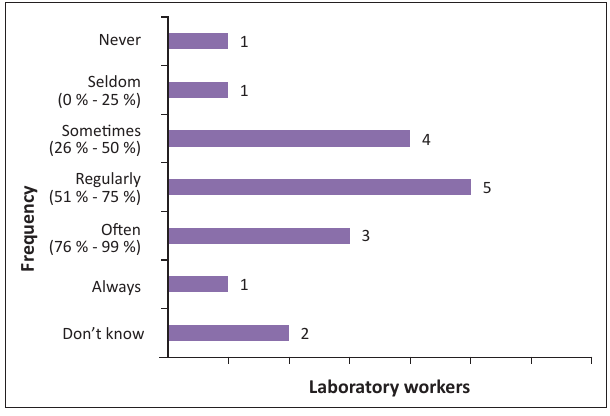
FIGURE 5: The frequency of professional contact between clinicians and laboratory workers. Eight of 16 clinicians reported having daily interactions with laboratory workers.